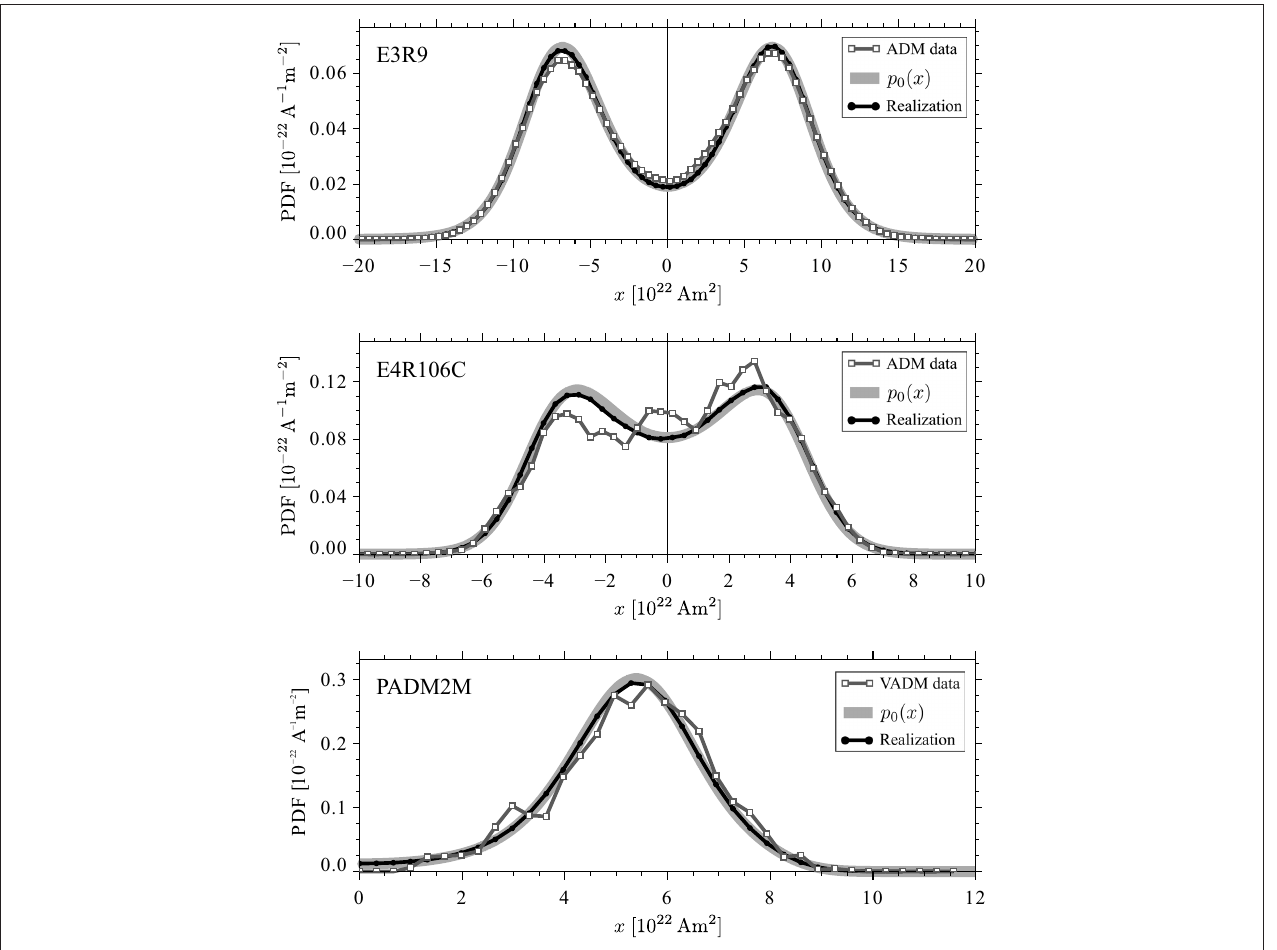
FIGURE 8 | Comparison of axial dipole moment probability distributions for the reversing dynamo models E3R9 (top panel) and E4R106C (middle panel), and for the palaeomagnetic model PADM2M (bottom panel). The binned probability density function of the original (V)ADM data is shown with open squares. The thick light gray curve is the analytical steady-state solution of the Fokker-Planck equation p 0 ( x ) (Equation 27) and the black curve is the PDF obtained from a long (several tens of thousand dipole decay times) numerical integration of the stochastic model.